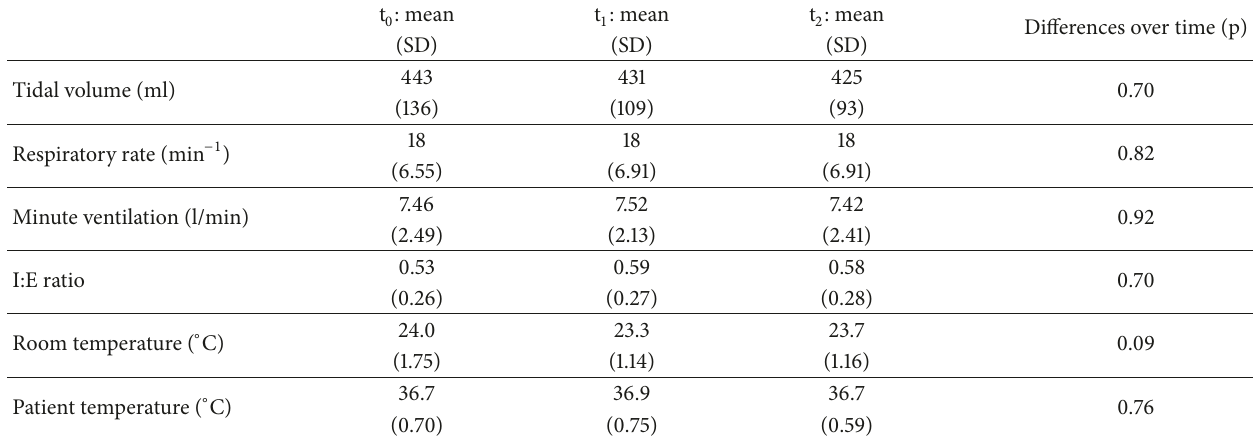
Table 1: Ventilatory variables at t 0 , t 1 , and t 2 assessment time; SD: standard deviation.